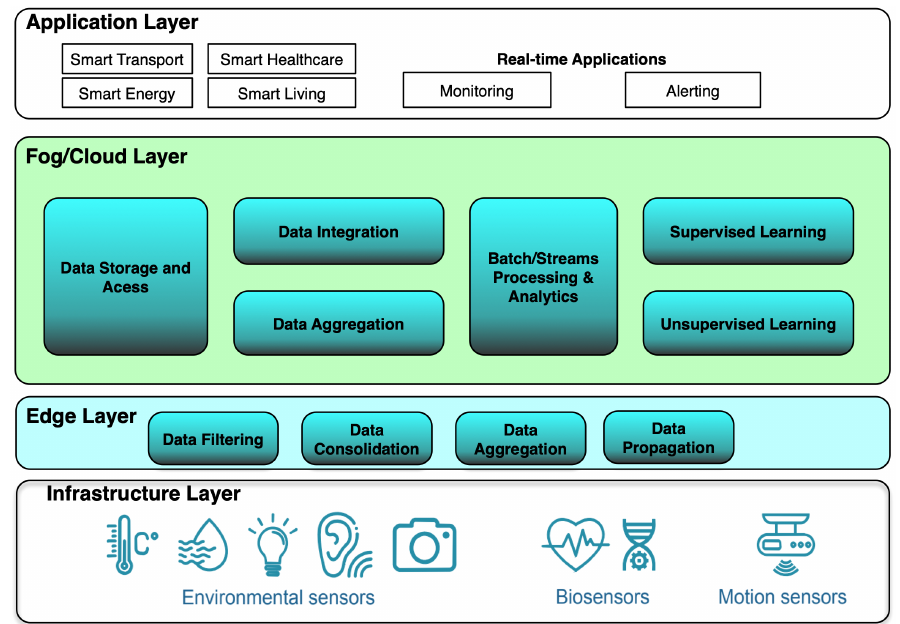
Figure 3. Data management operations at the edge–cloud